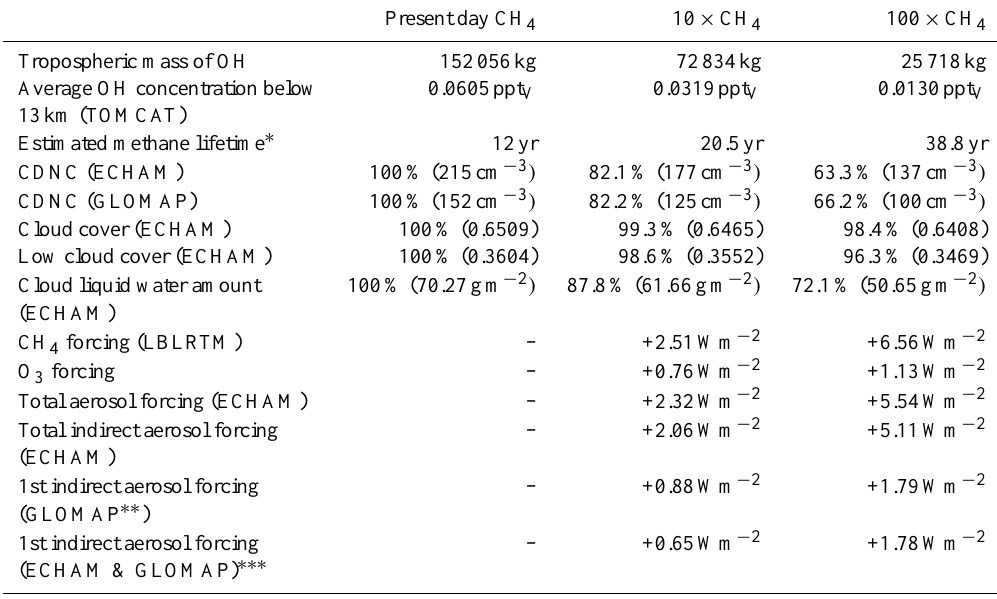
Table 1. Average tropospheric OH concentration, estimated methane lifetime, global mean cloud droplet number concentration (CDNC), changes in the global-mean total and cloud cover and liquid water path, and various radiative forcing components (computed with respect to the present-day atmosphere) associated with three different methane concentrations. For CDNC and other cloud parameters, numbers shown in brackets are absolute values. O 3 and CH 4 forcings are computed at the tropopause, and aerosol-related forcings at the top of the atmosphere. LBLRTM = Line By Line Radiative Transfer Model. See the Computational Details – section for